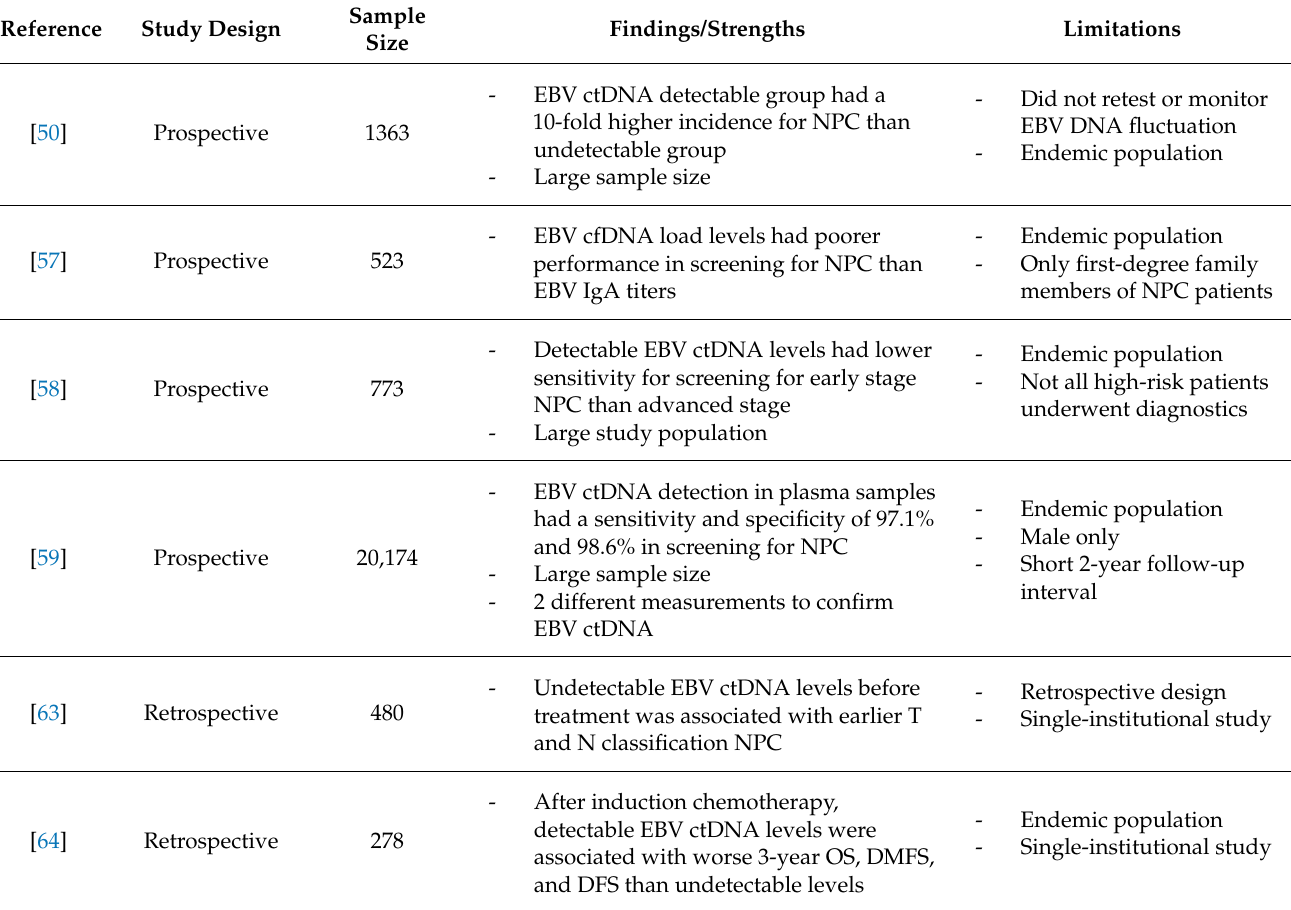
Table 2. Key studies examining EBV ctDNA as a biomarker for EBV-associated NPC. Reference Study